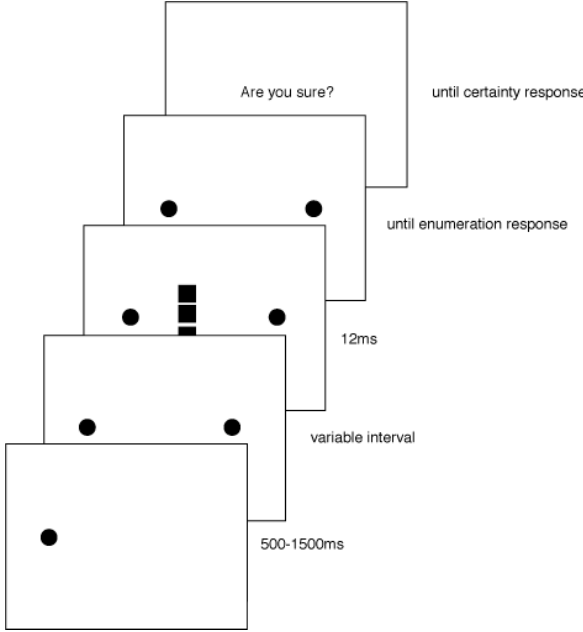
Figure 1. Series of events in a typical trial in the current study. Each trial began with a fixation dot on the left side of the screen. After a random interval between 500-1500ms, a second dot appeared on the right side of the screen and a beep sounded to signal the observer to execute a saccade. After a variable interval based on a running mean of the observer's saccade reaction time, 0-4 squares appeared for 12 ms. Each square appeared in one of 41 possible locations, and multiple squares were always aligned horizontally, diagonally, or vertically. The fixation points remained on the screen until observers responded about the number of items they thought had been presented (0 to 4). This response brought up a prompt asking if they were sure (yes or no). The response to the question of certainty started the next